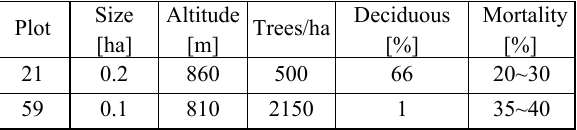
Table 2. Characteristics of sample plots